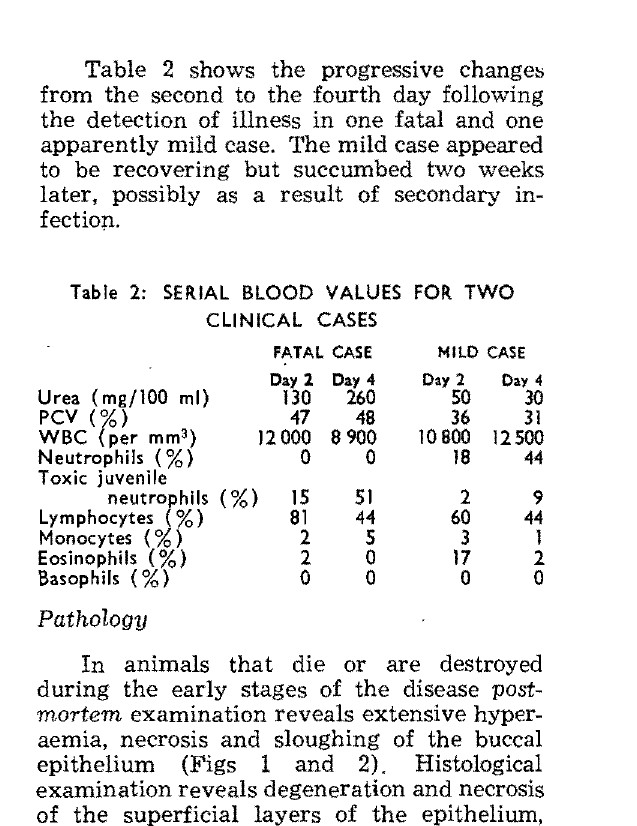
Table 1: MEAN BLOOD VALUES FOR SEVERE